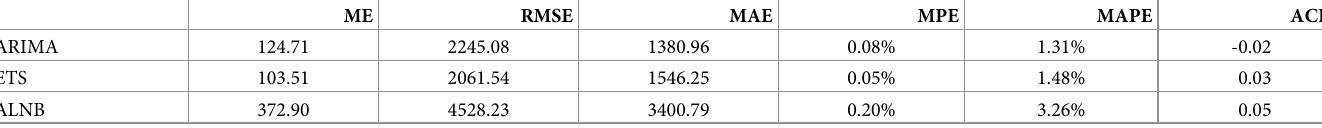
Table 1. Accuracy measures for the models over the Brazilian data from January 2015 to December 2019.